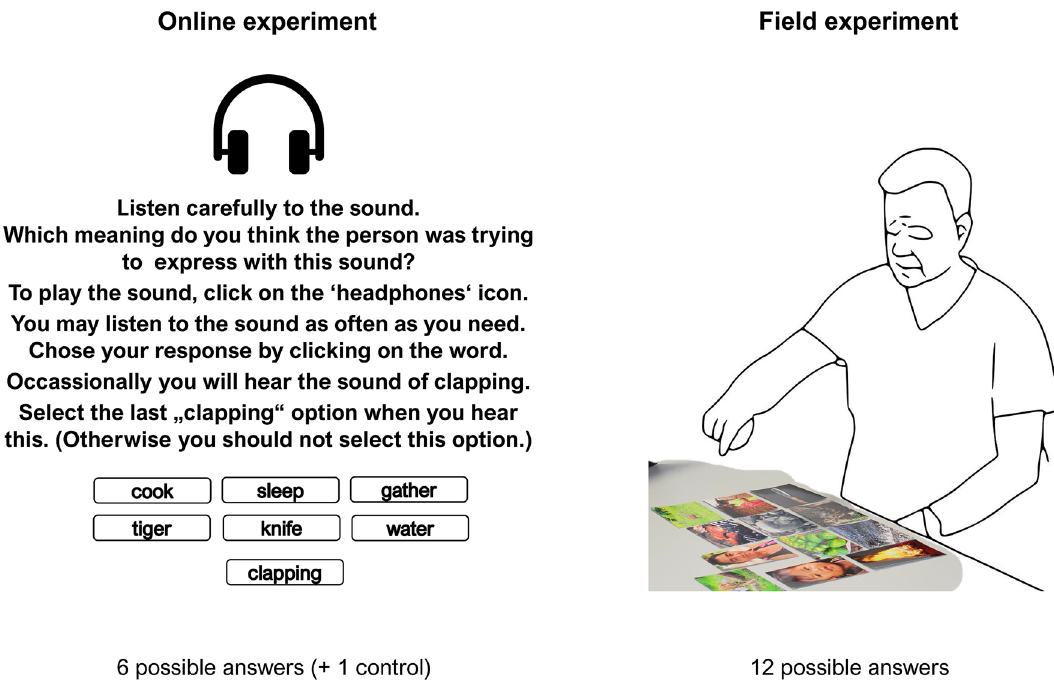
Figure 1. Experimental setup for online and fieldwork versions of the